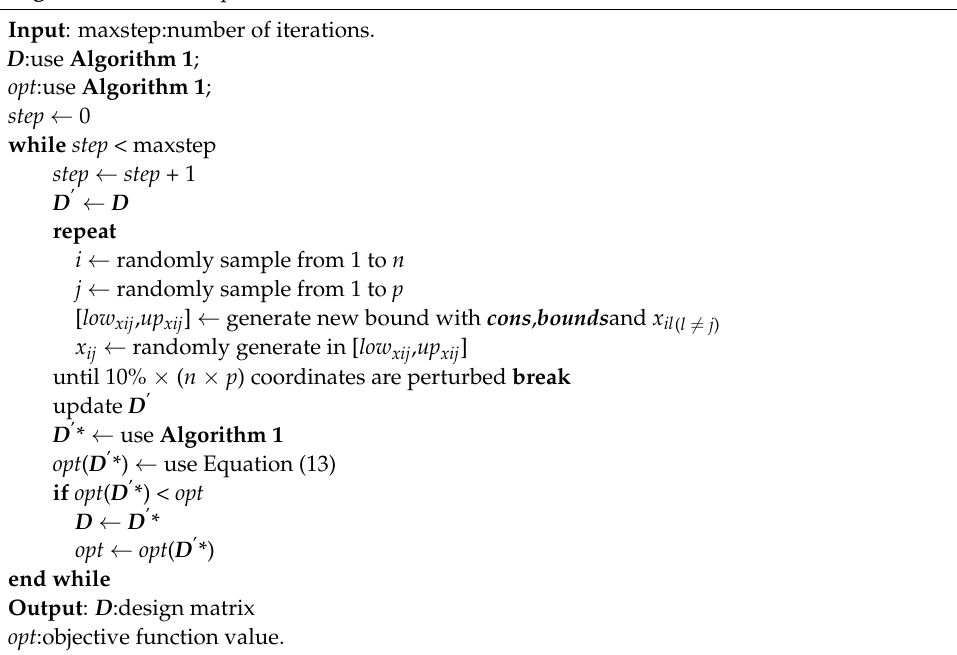
Algorithm 2 Iterated